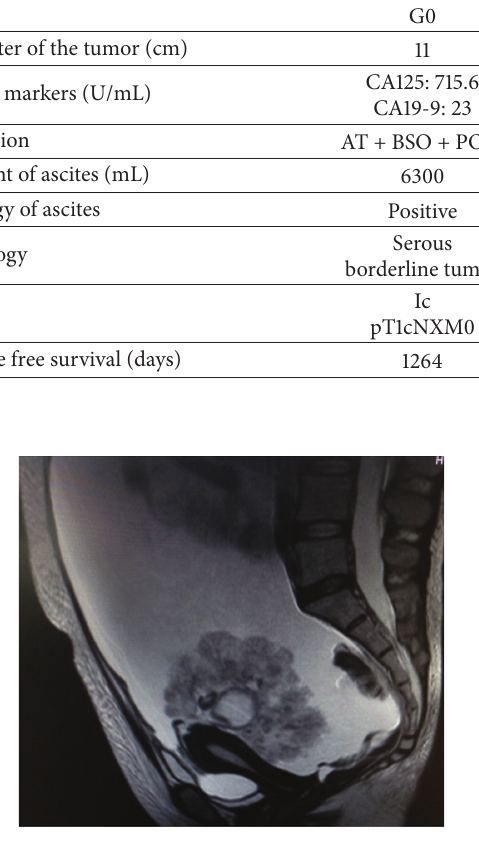
Figure 1: MRI image of patient 1 before operation.